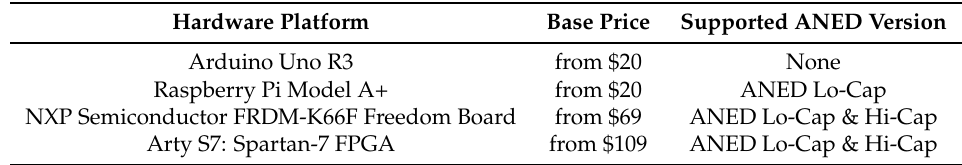
Table 3. Price comparison for the hardware platforms described and algorithm they can assume real-time. Hardware